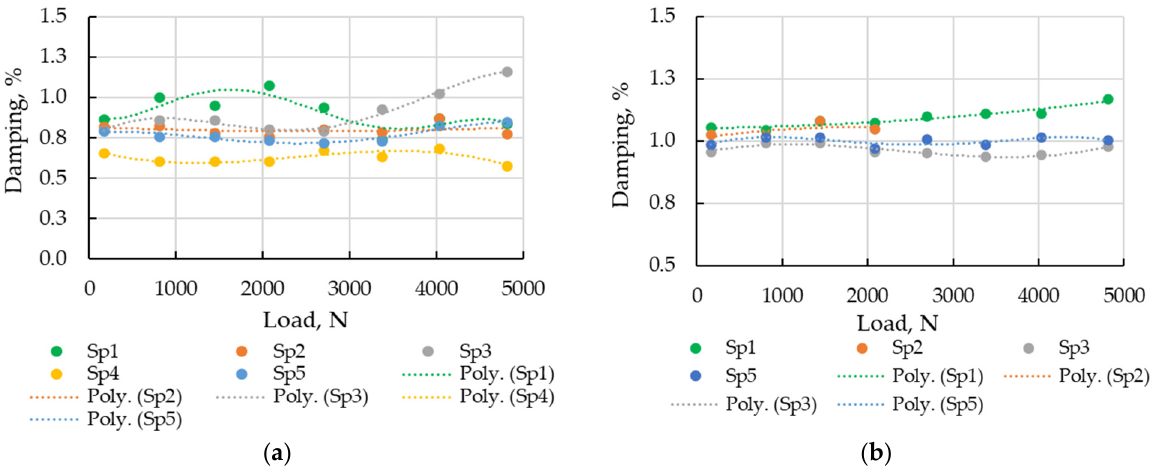
Figure 10. Damping elevation to static load for di ff erent specimens: ( a ) mode (1;5); ( b ) mode (1;2 ′ ).